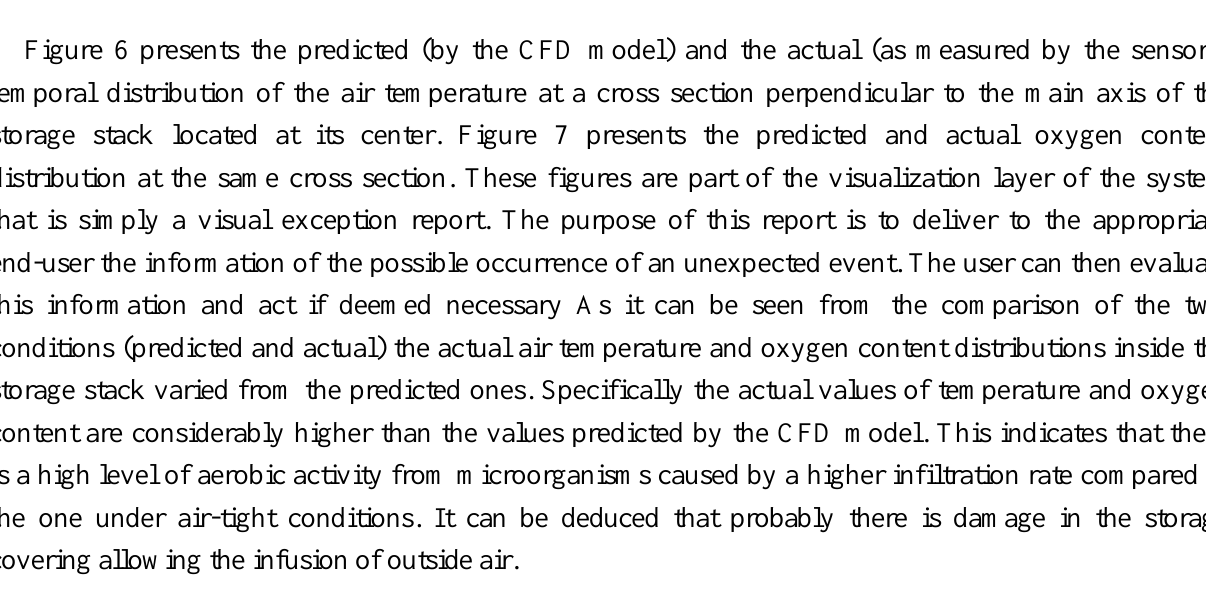
Figure 6. The predicted temporal distribution of the air temperature (at the stack center) by the CFD model (left) and the actual distribution according to the sensor